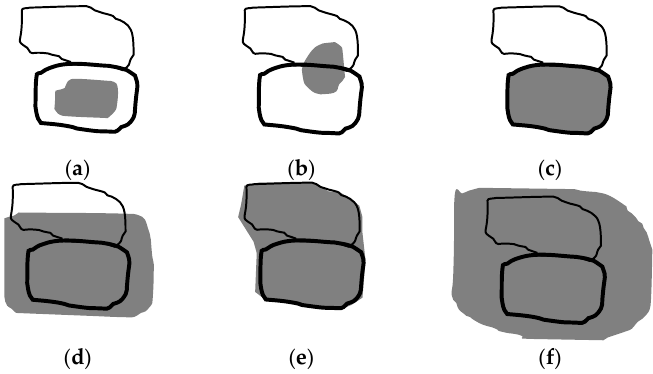
Figure 2. Possible distributions of a changed object and its relevant changed area, whose statistical feature variation is described as above ( a )–( f ).